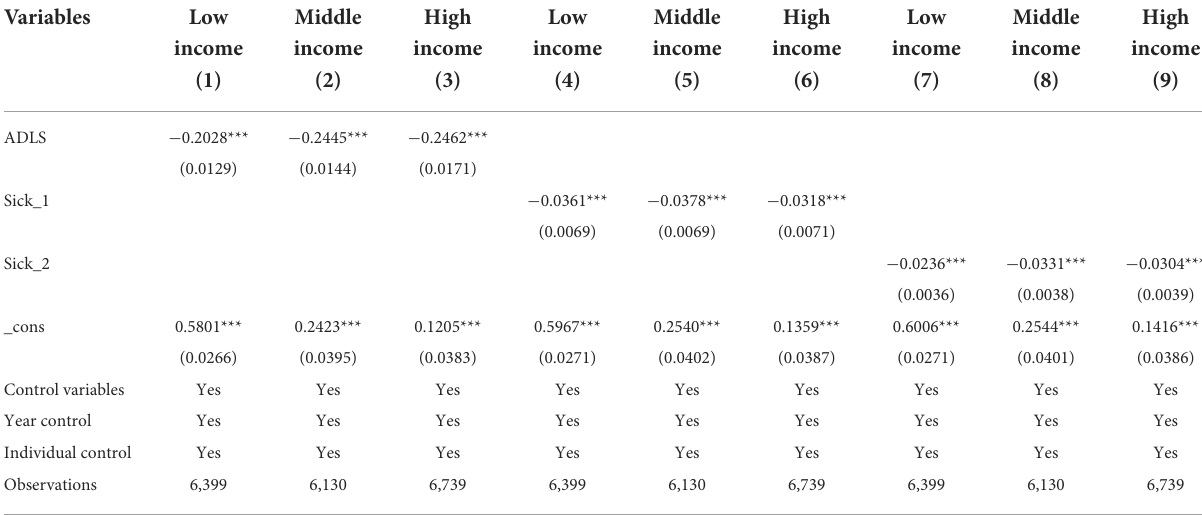
TABLE 8 The mediating effect of medical insurance under different income groups.